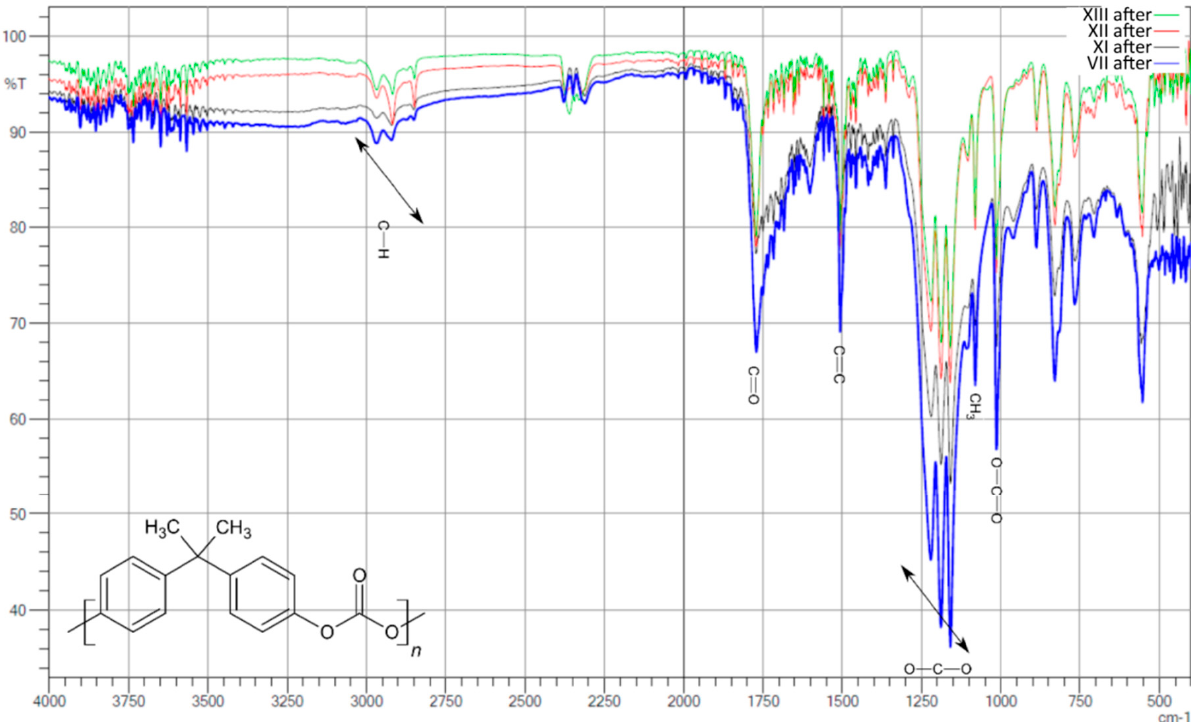
Figure 5. Compilation of IR spectra before aging for samples XIII, XII, XI, and VII.